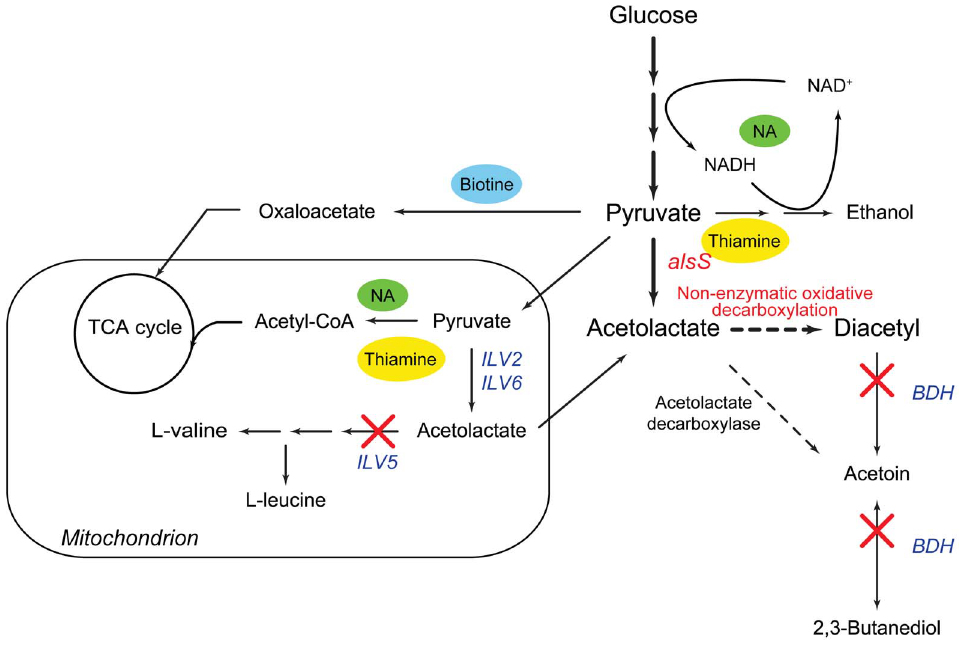
Figure 1. Illustration of diacetyl metabolic pathway and pyruvate metabolism in engineered C.glabrata . The red marks indicate metabolic modifications performed in this study, and the cytosolic ALS encoded by alsS was from B. subtilis . Additional descriptions of the reactions with thiamine and NA as cofactors are provided in Table S1.